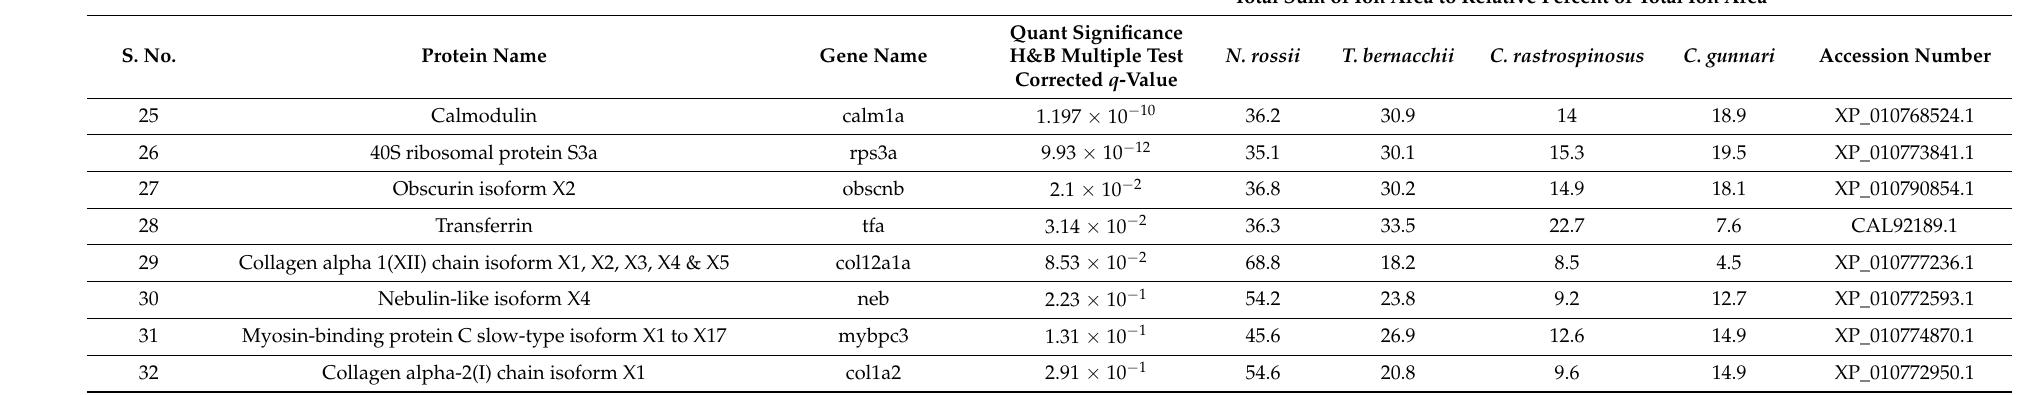
Protein Abundance—Lower in Icefish (White